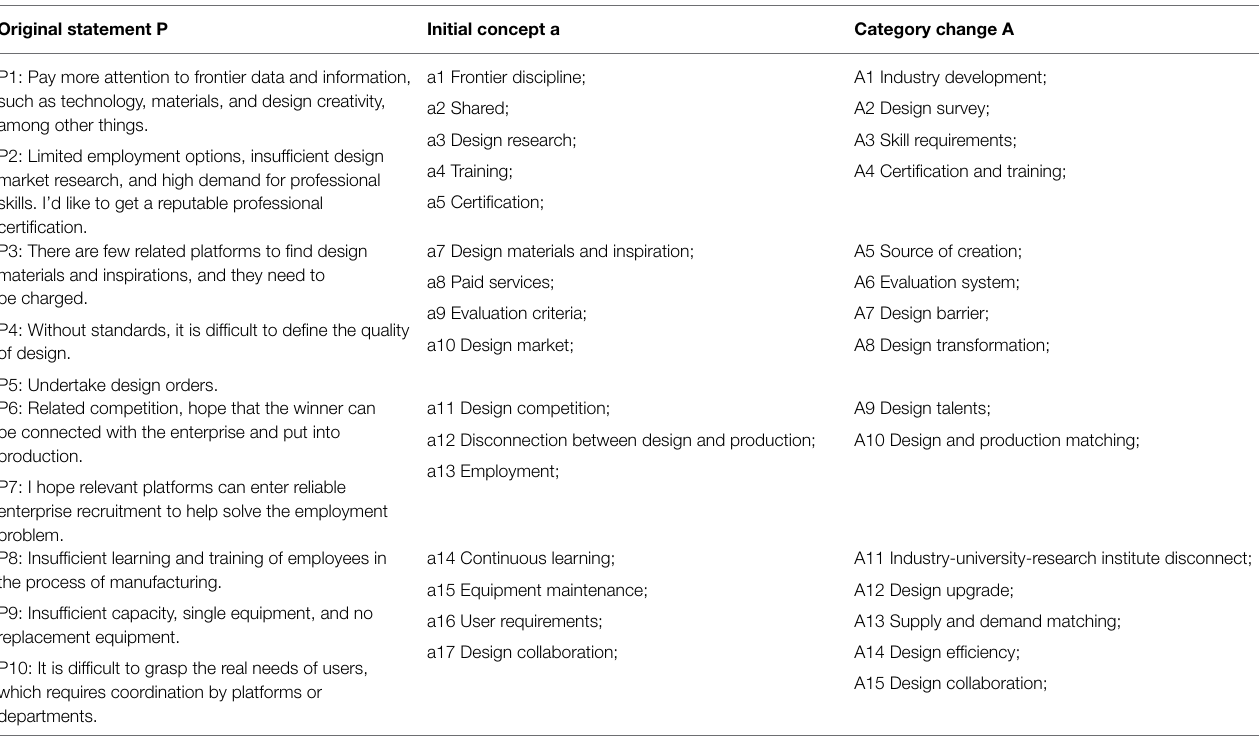
TABLE 1 | Open coding categorization (partial